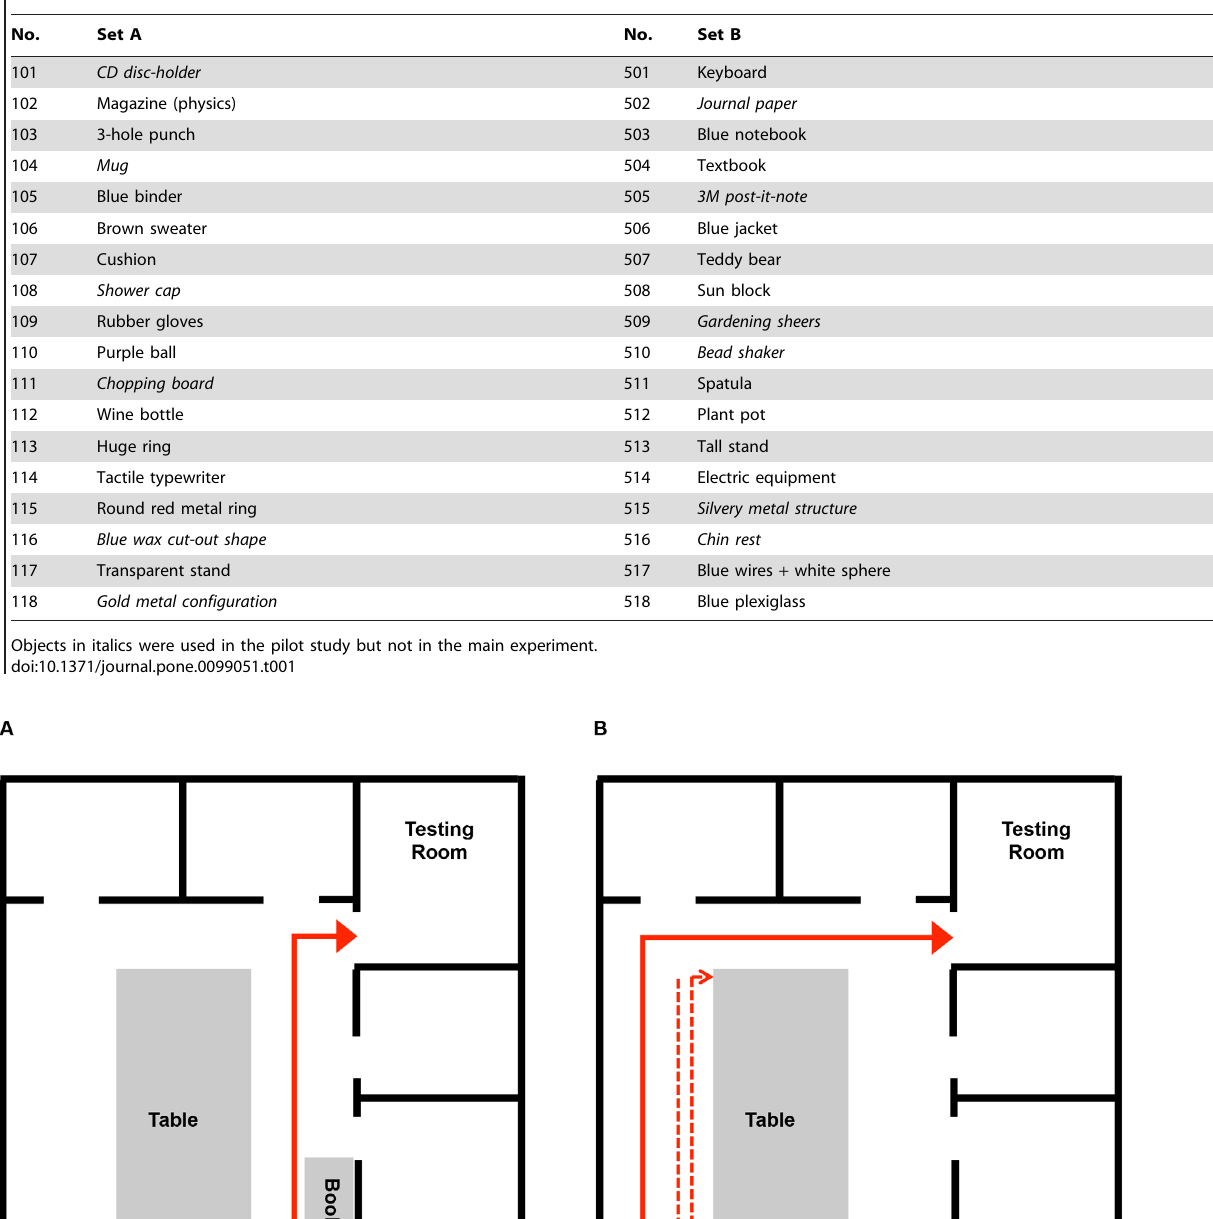
Table 1. Two sets of stimulus objects.